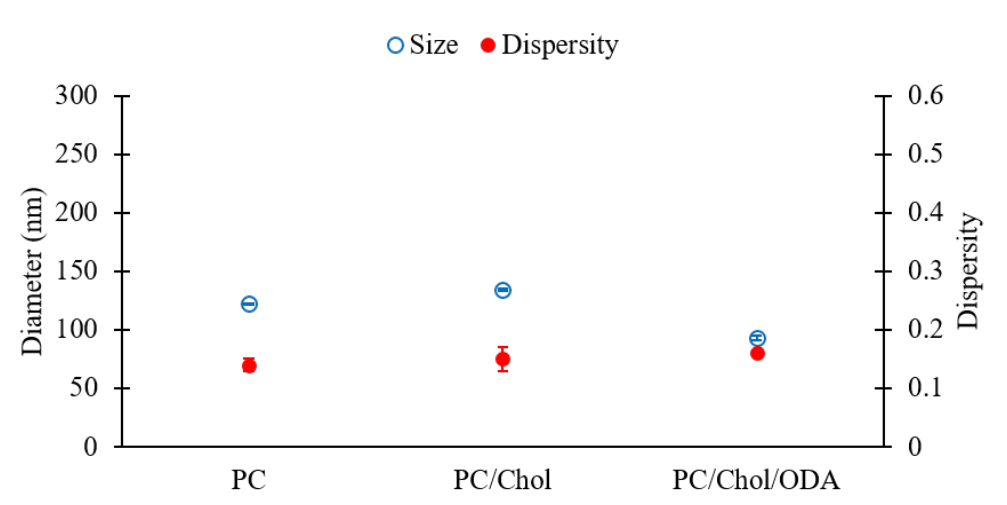
Figure 9. Z-average sizes (left y-axis, empty blue circles) and dispersity values (right Y-axis, filled red circles) of liposomes consisting of di ff erent lipid formulations. Data represent the means of three measurements with corresponding standard deviations. Refer to Table 1 (batch codes #13 PC, #20 PC, #25 PC) for the corresponding experimental conditions, lipid compositions, and numerical data of mean values and standard deviations.